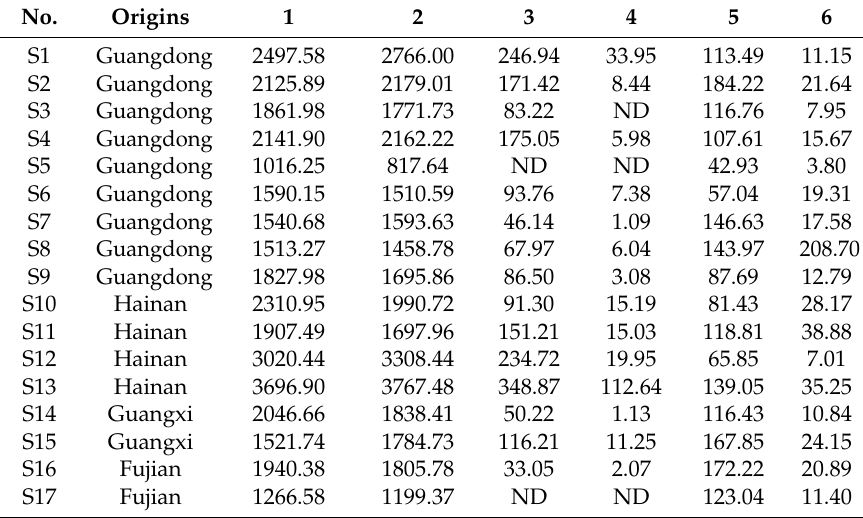
Table 4. Quantitative analytical results of M. officinalis ( µ g/g, n =